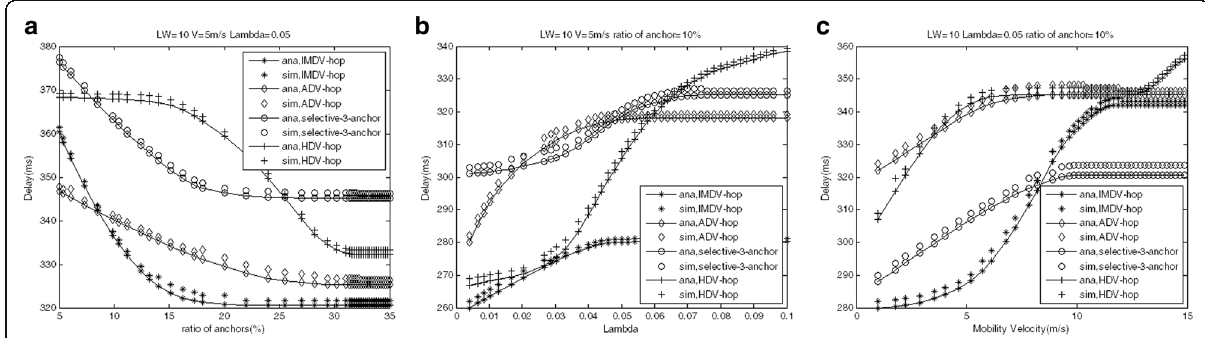
Fig. 11 Localization delay comparisons. a Localization delay comparisons for different schemes based on the ratio of anchors. b Localization delay comparisons for different schemes based on node density. c Localization delay comparisons for different schemes based on mobility